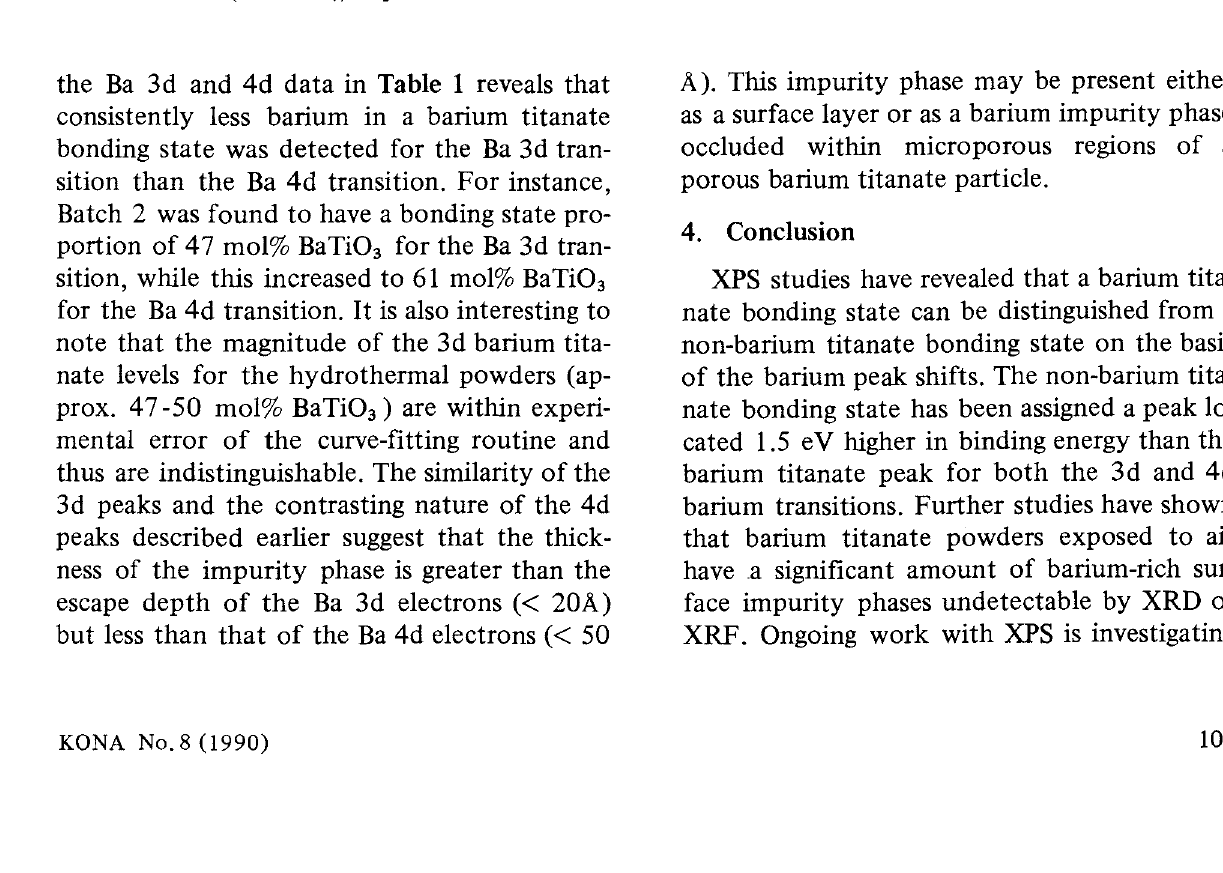
Fig. 2 Comparison between Ba 3d XPS data versus XRD data for several partially reacted hydro thermal barium titanate